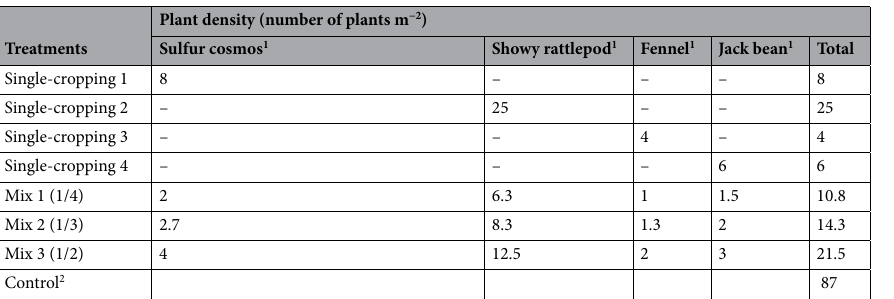
Table 1. Plants density in the assessed treatments. Seropédica, RJ, Brazil, May to November 2017. 1 sulfur cosmos = Cosmos sulphureus (Asteraceae) ; showy rattlepod = Crotalaria spectabilis (Fabaceae); fennel = Foeniculum vulgare (Apiaceae); jack bean = Canavalia ensiformis (Fabaceae). 2 Weeds (12 botanical species m−2 on